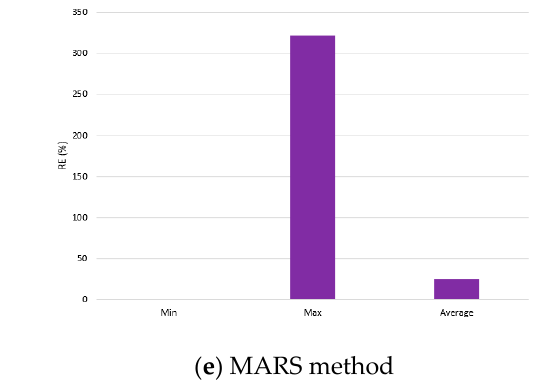
Figure 10. Comparison between RE of different models.